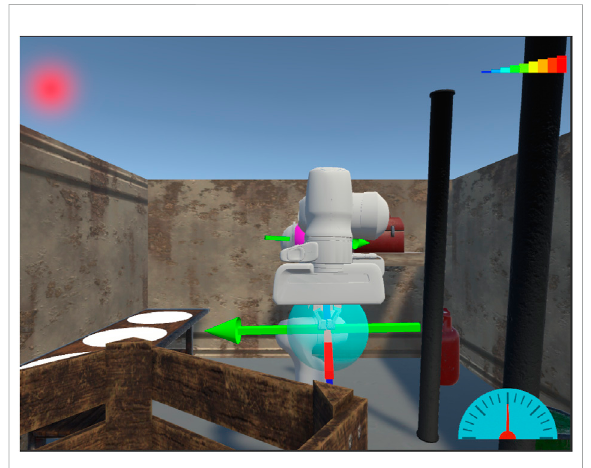
FIGURE 5 The heads up display elements. Proximity is displayed using the red dot in the top left, the maximum value is displayed. Radiation is displayed using the coloured bars in the top right, the maximum value is displayed. Load is displayed on the gauge in the bottom right, a middle value is